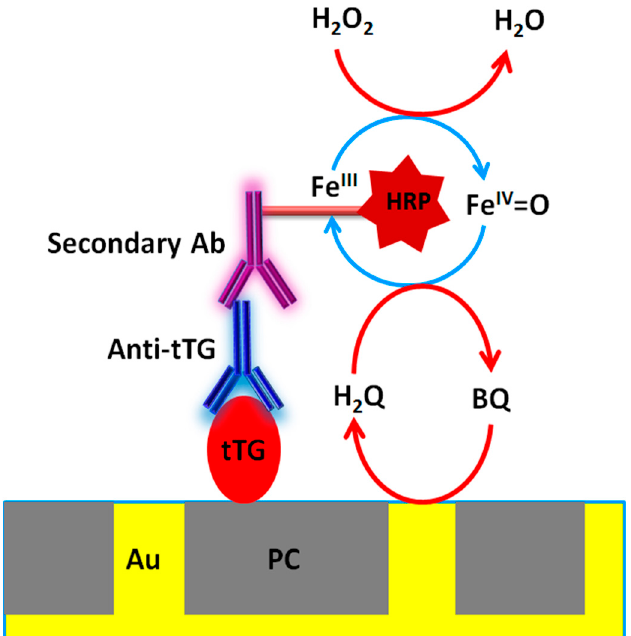
Scheme 1. Scheme depicting the immunosensor architecture and the associated electrochemical and enzymatic processes, where PC= polycarbonate; tTG= tissue transglutaminase; Anti-tTG= antibody for tissue transglutaminase; HRP= horseradish peroxidase; H 2 Q= hydroquinone; BQ=